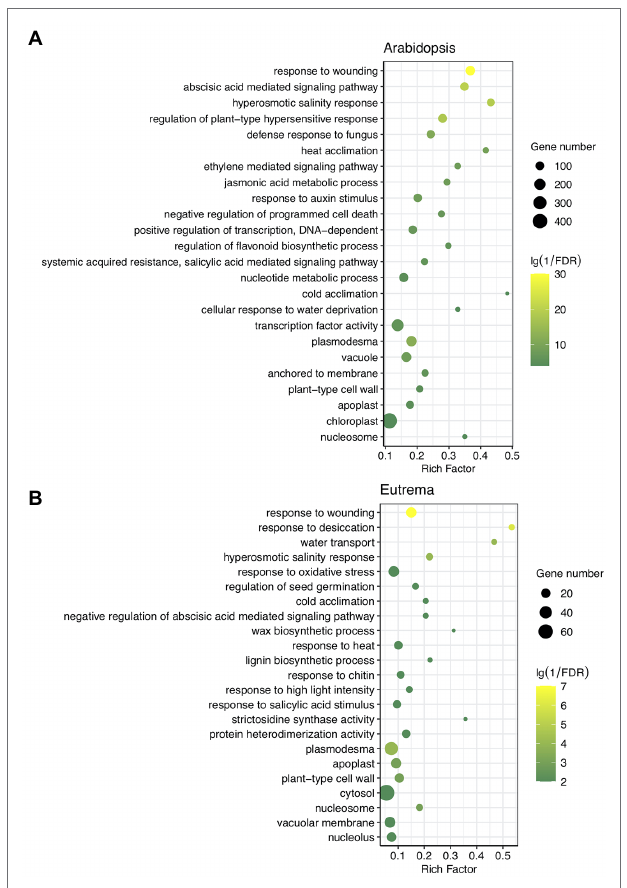
FIGURE 3 | Gene ontology (GO) analysis of differentially expressed PAC genes (DE-PAC genes) in Arabidopsis (A) and Eutrema (B) . Rich factor indicates the gene number annotated in the term divide by the gene number in reference annotation. FDR, false discovery rate. The size of the dot indicates the number of genes; the color indicates significance.